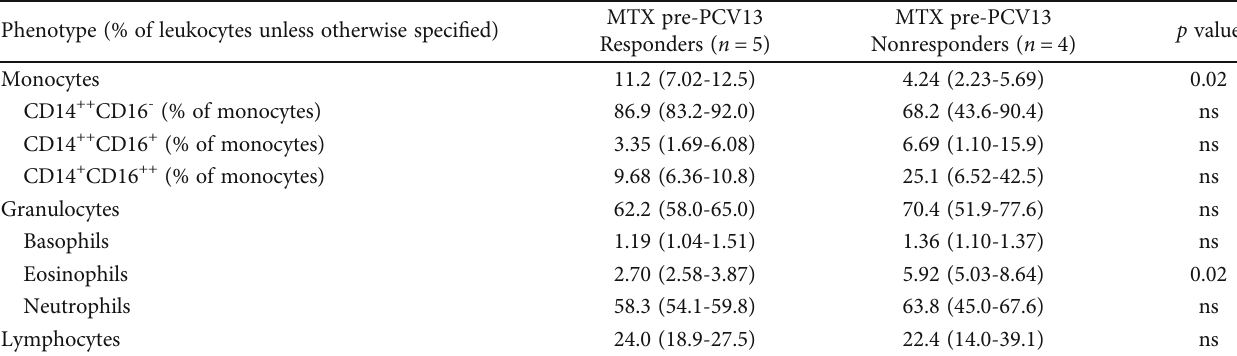
Table 4: Frequencies of circulating leukocytes in RA patients with MTX treatment, before vaccination with PCV13, sorted in responders and